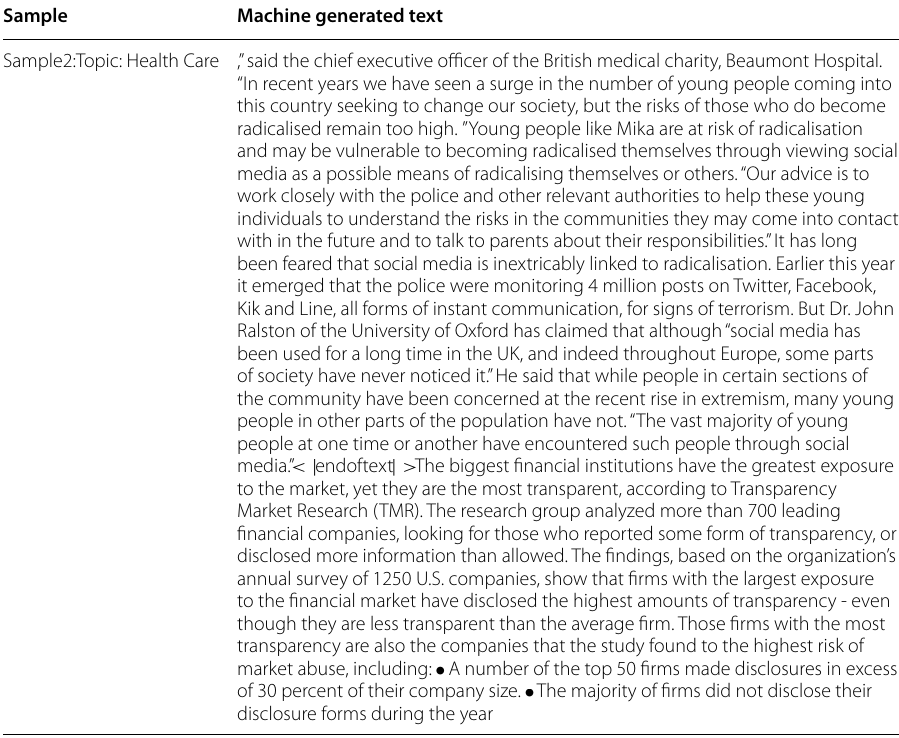
Automatic output generated by the trained model